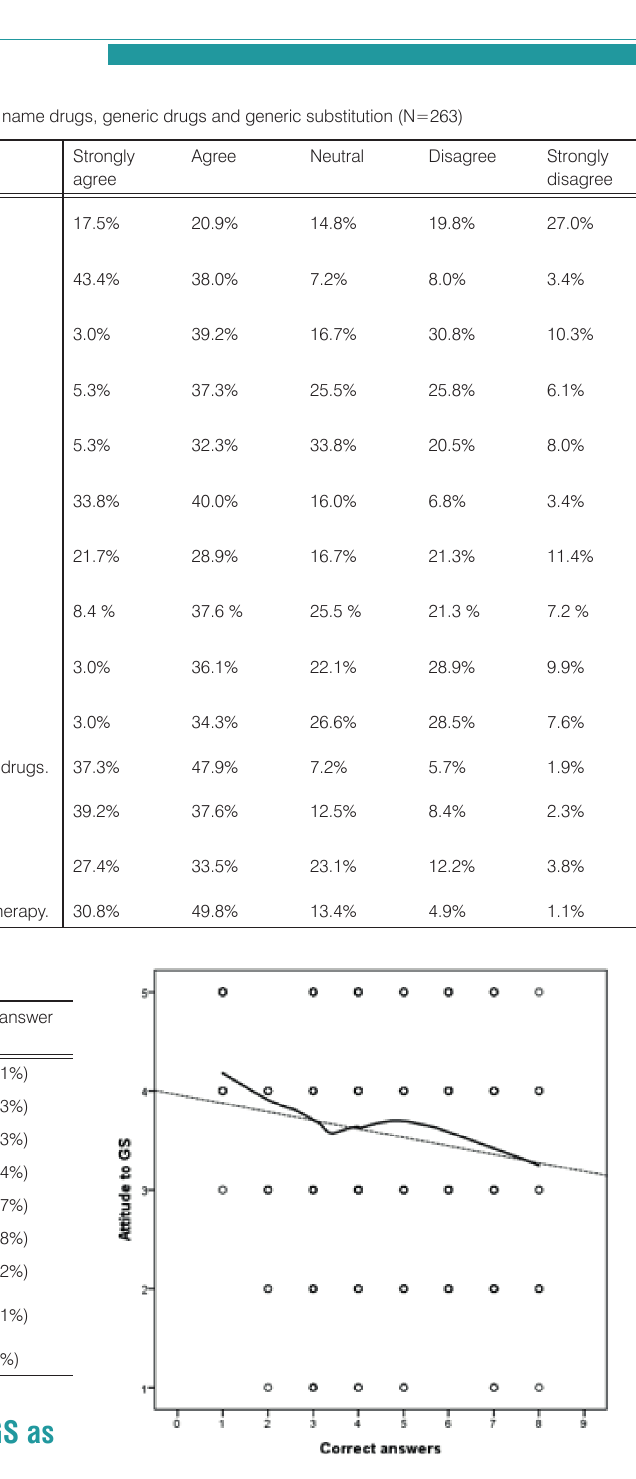
Figure 1. Correlation between the attitude towards GS and under- standing of the legislation for GS Legend: y axis: attitude towards GS (1–very positive, 2–positive, 3–neutral, 4–negative, 5–very negative); x axis: understanding of the legisla- tion for GS (each correct answer scored one point out of maximal nine points); the line is a fi tted local regression (loess)